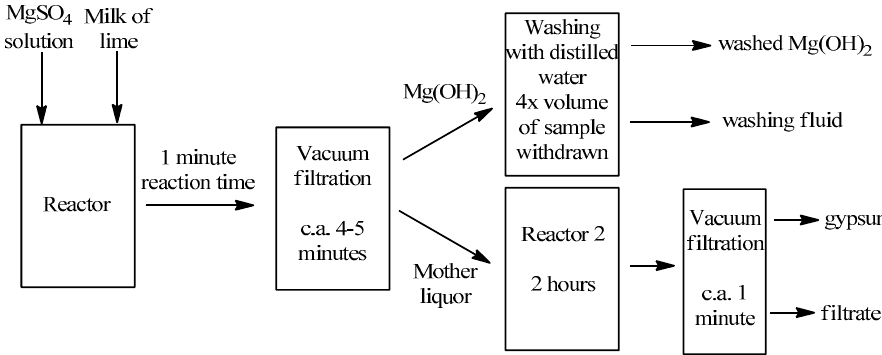
Scheme 2. Experimental procedure for separating the precipitating solids during the MgSO 4 + Ca(OH) 2 + 2 H 2 O → Mg(OH) 2 + CaSO 4 ·2H 2 O reaction.